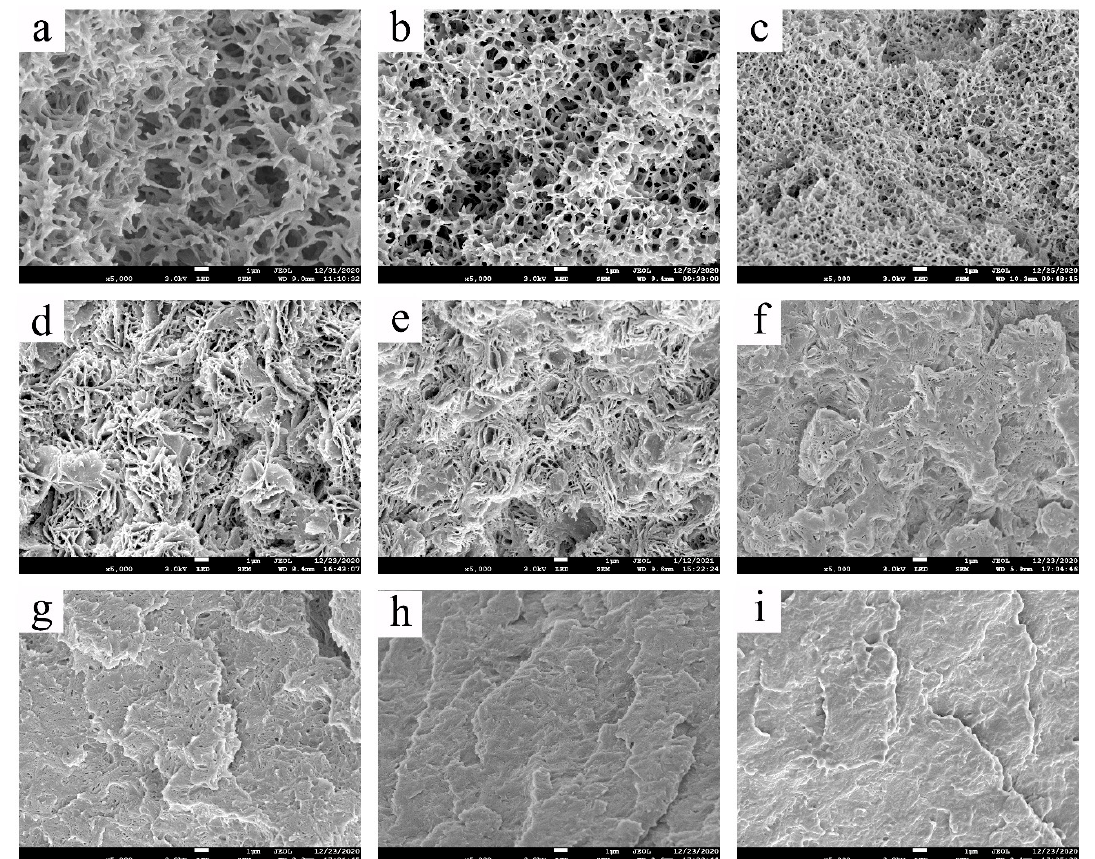
Figure 6. The cross-section structure of the PMP-MA piece membranes with different PMP concentrations: ( a – i ) shows 10, 20, 30, 40, 50, 60, 70, 80, and 90 wt%, respectively.